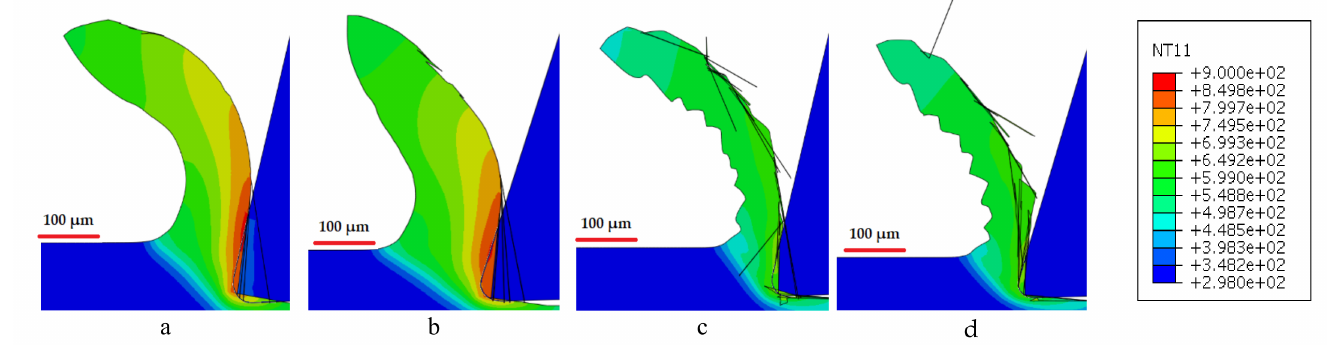
Figure 6. Temperature contour (in K) of ( a ) JC_1, ( b ) JC_Hou_2, ( c ) JC-Calamaz_3 and ( d ) JC-MTANH_3 for h = 60 µ m at 850 µ s of cutting